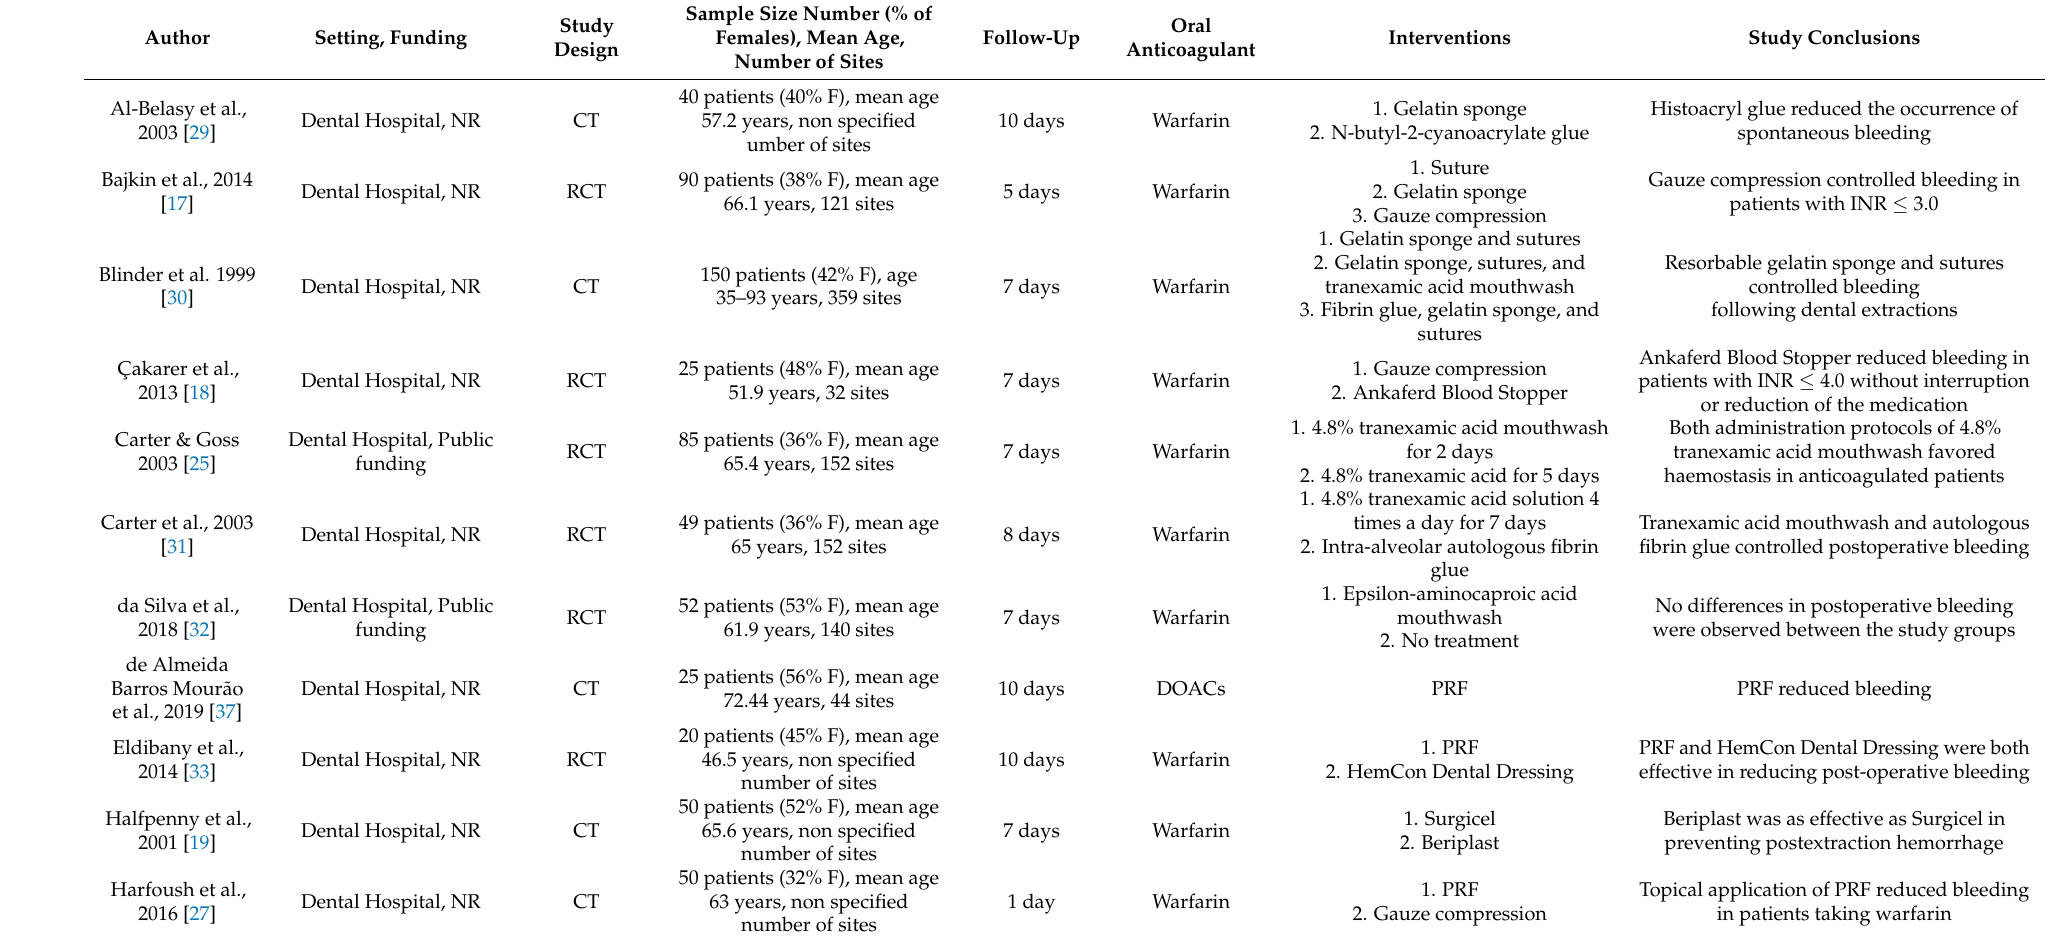
Table 1. Summary of main